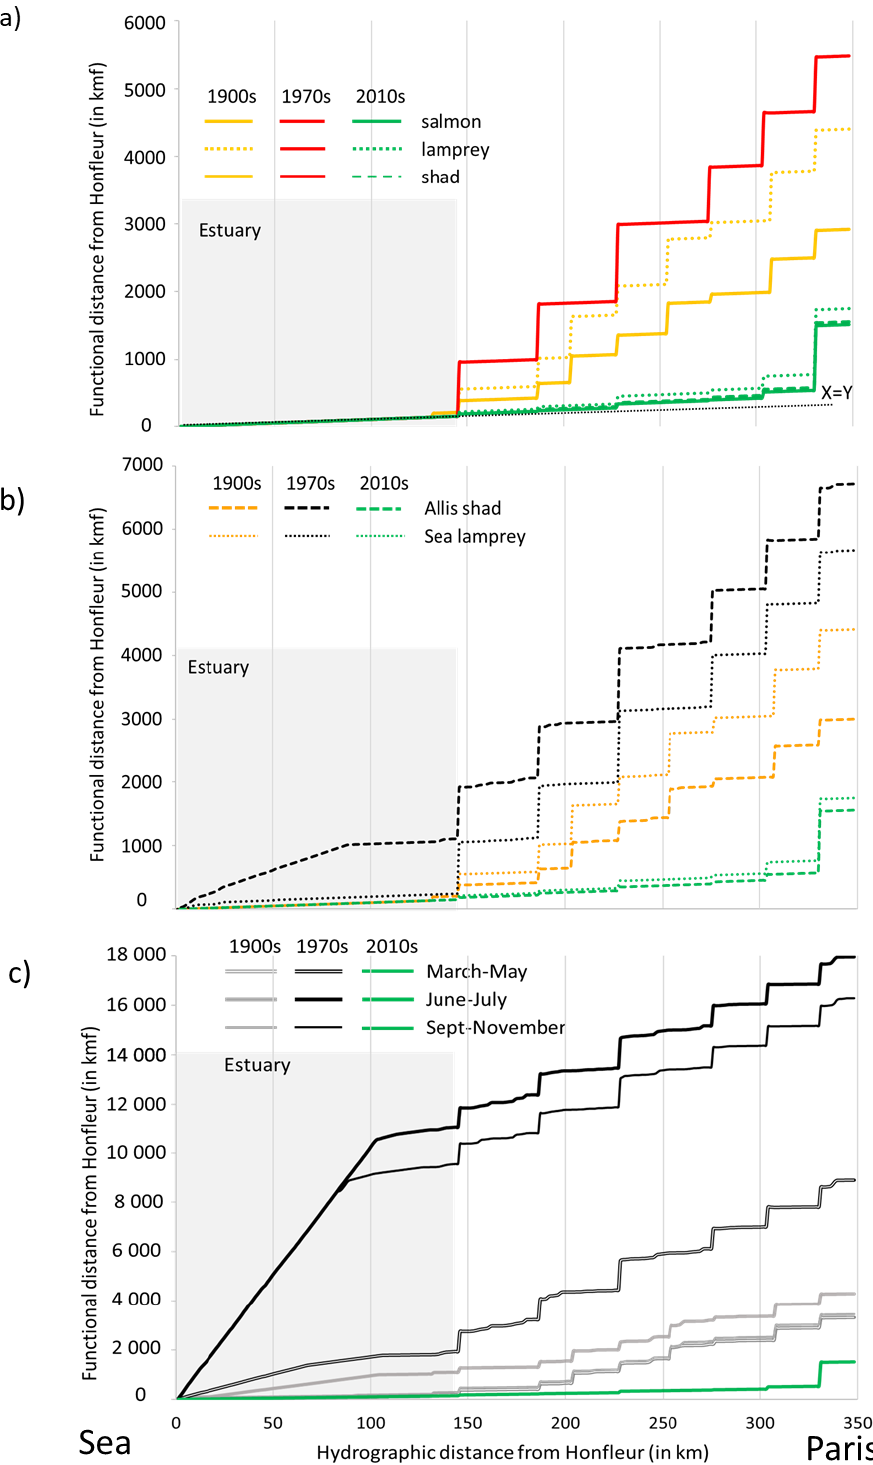
Figure 5. Accessibility from the sea to Paris, calculated in functional kilometers in relation to hydrographic distances. ( a ) Accessibility calculated with only physical barriers for the three species and time periods. The X = Y line is indicated. ( b ) Accessibility calculated for allis shad and sea lamprey for the physical and chemical barriers scenario and time periods. ( c ) Accessibility for Atlantic salmon in relation to migration periods and time